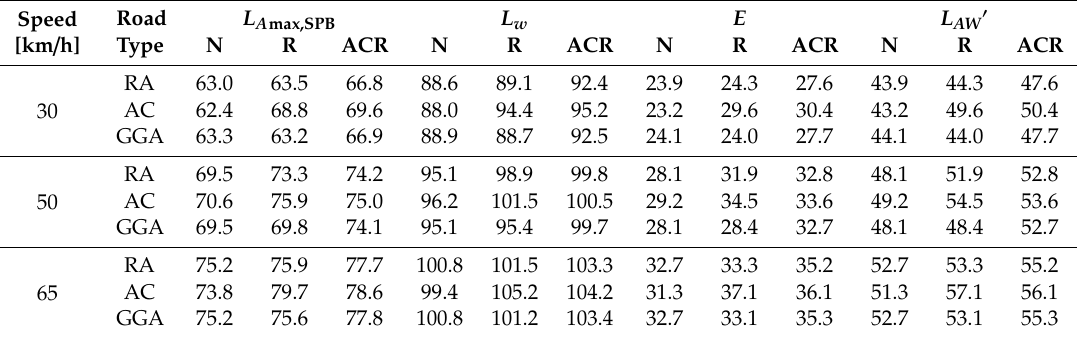
Table 4. Noise indicators for each speed and pavement type